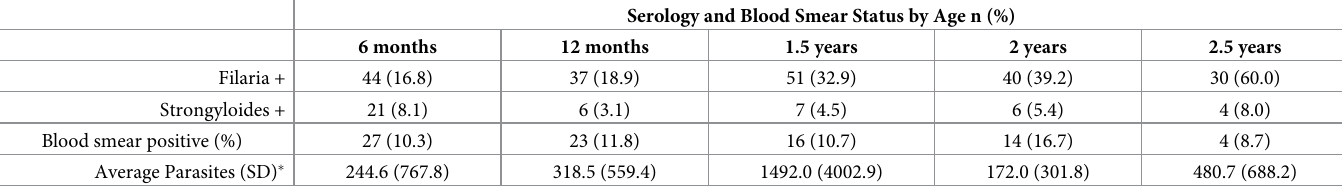
Serology and Blood Smear Status by Age n